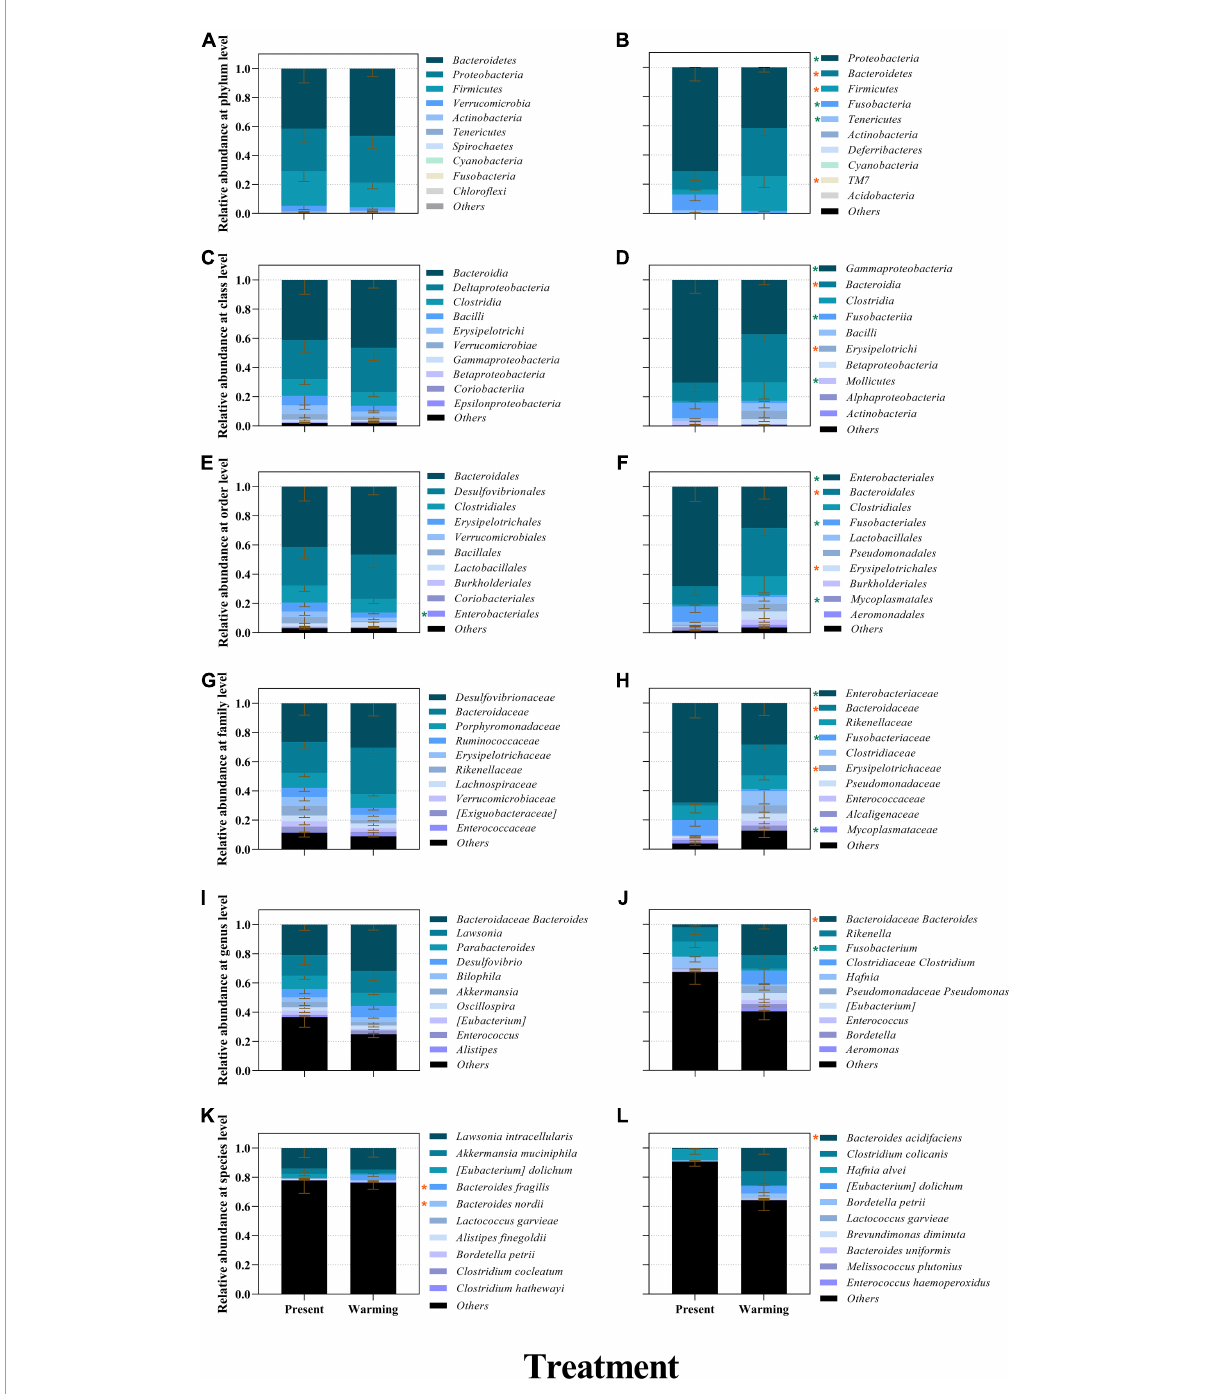
FIGURE4 The relative abundance of bacterial compositions of Eremias argus (A,C,E,G,I,K) and Takydromus amurensis (B,D,F,H,J,L) at different levels ( A,B : phylum; C,D : class; E,F : order; G,H : family; I,J : genus; K,L : species). Different colors in the figures indicate the different groups, and details are shown on the right sides of each figure, respectively. Present and warming indicate present and warming climate conditions, respectively. Data are shown as mean ± standard error (SE). Orange and green asterisks indicate significant upregulation and downregulation of warming climate conditions against the present climate conditions, respectively ( P <